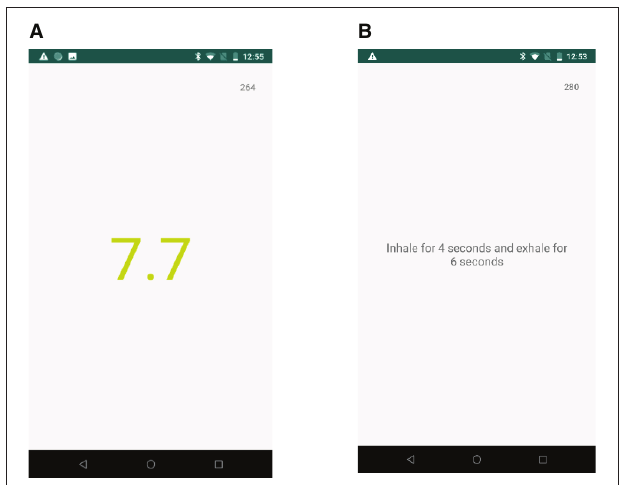
TABLE 2 | Effect of breathing rate and its rate of change on the number of balls in the arena ( N b ) and ball travel time T BR . Scaling factor ( α ) for BR > 6 is obtained from Figure 2 .